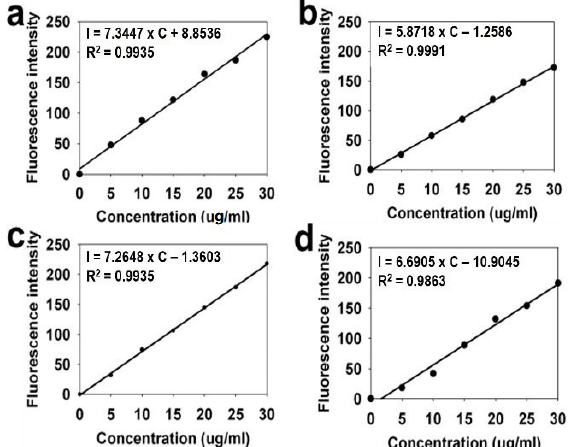
Figure 5. Fluorescence of phycobiliproteins with respect to their concentration correlation of fluorescence intensity with concentration of phycobiliproteins; ( a ): Control C-Pc; ( b ): Fraction 1; ( c ): Fraction 2; ( d ): Fraction 3.